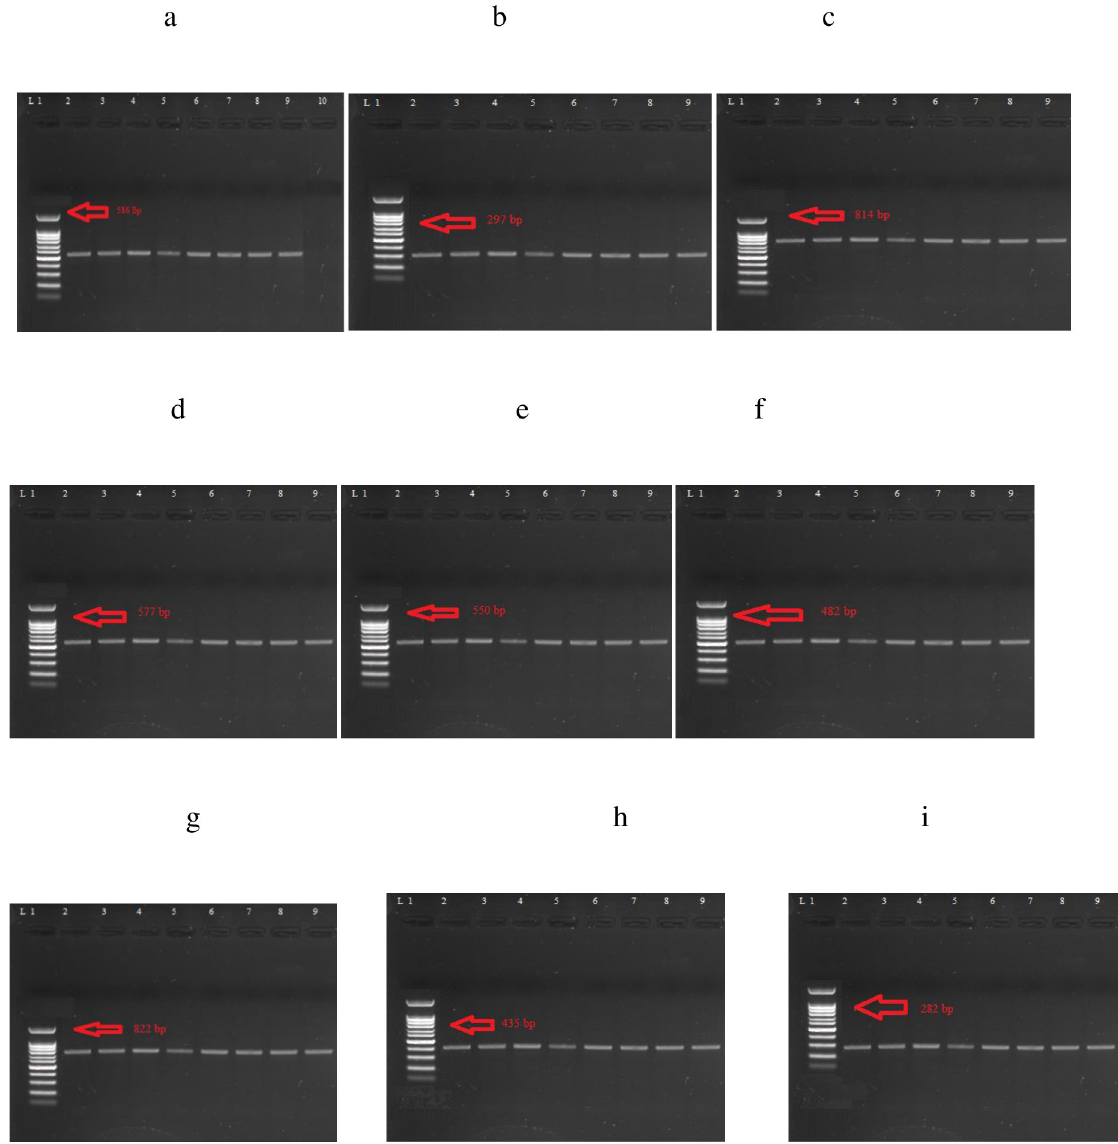
Fig 6. A.CTXM 15: 1; DNA Ladder, 2; positive control, 3–9; positive for CTXM-15 (bp = 586), B. TEM 1: 1; DNA Ladder, 2–9; positive for TEM 1 (bp = 297), C. OXA 1: 1; DNA Ladder, 2; positive control, 3–9 positive for OXA 1 (bp = 814), D.TET A: 1; DNA Ladder, 2; positive control, 3–9; positive isolates for TET A (bp = 577), E. QNRS: 1; DNA Ladder, 2–9; positive isolate for QNR S (bp = 550), F. AAC(6)-Ib-cr: 1; DNA Ladder, 2–9 positive isolate for AAC(6)-Ib-cr (bp = 482), G. SUL 1: 1; DNA Ladder, 2–9; positive isolate for SUL 1 (bp = 822), H. SUL 2: 1; DNA Ladder, 2–9 positive isolate for SUL 2 (bp = 435), I. aad A1: 1; DNA Ladder, 2–9 positive isolate for aad A1(bp =